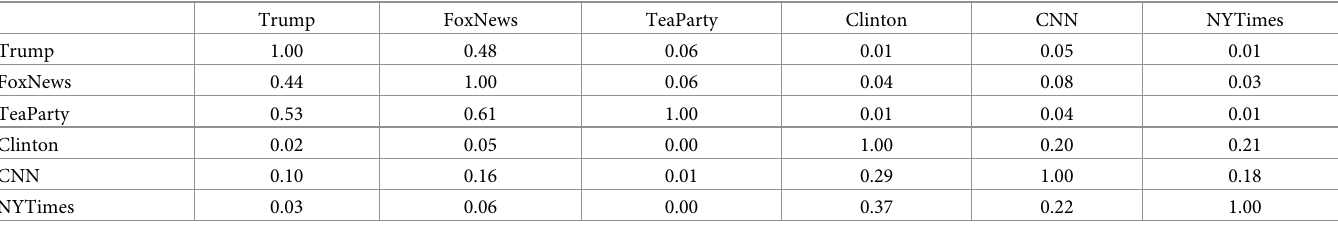
Table 3. Agreement matrix